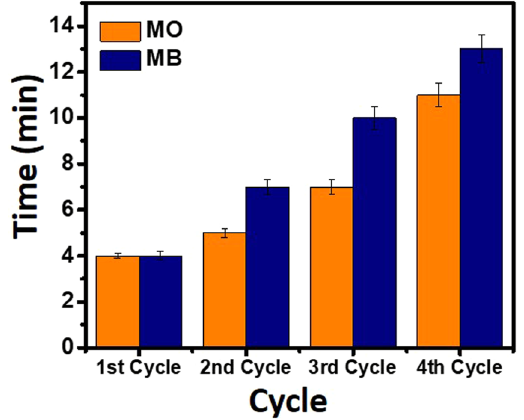
Figure 13. Recyclability of MO and MB showing their complete reduction versus time in the presence of 25 mg of Cu/CS-TiO 2